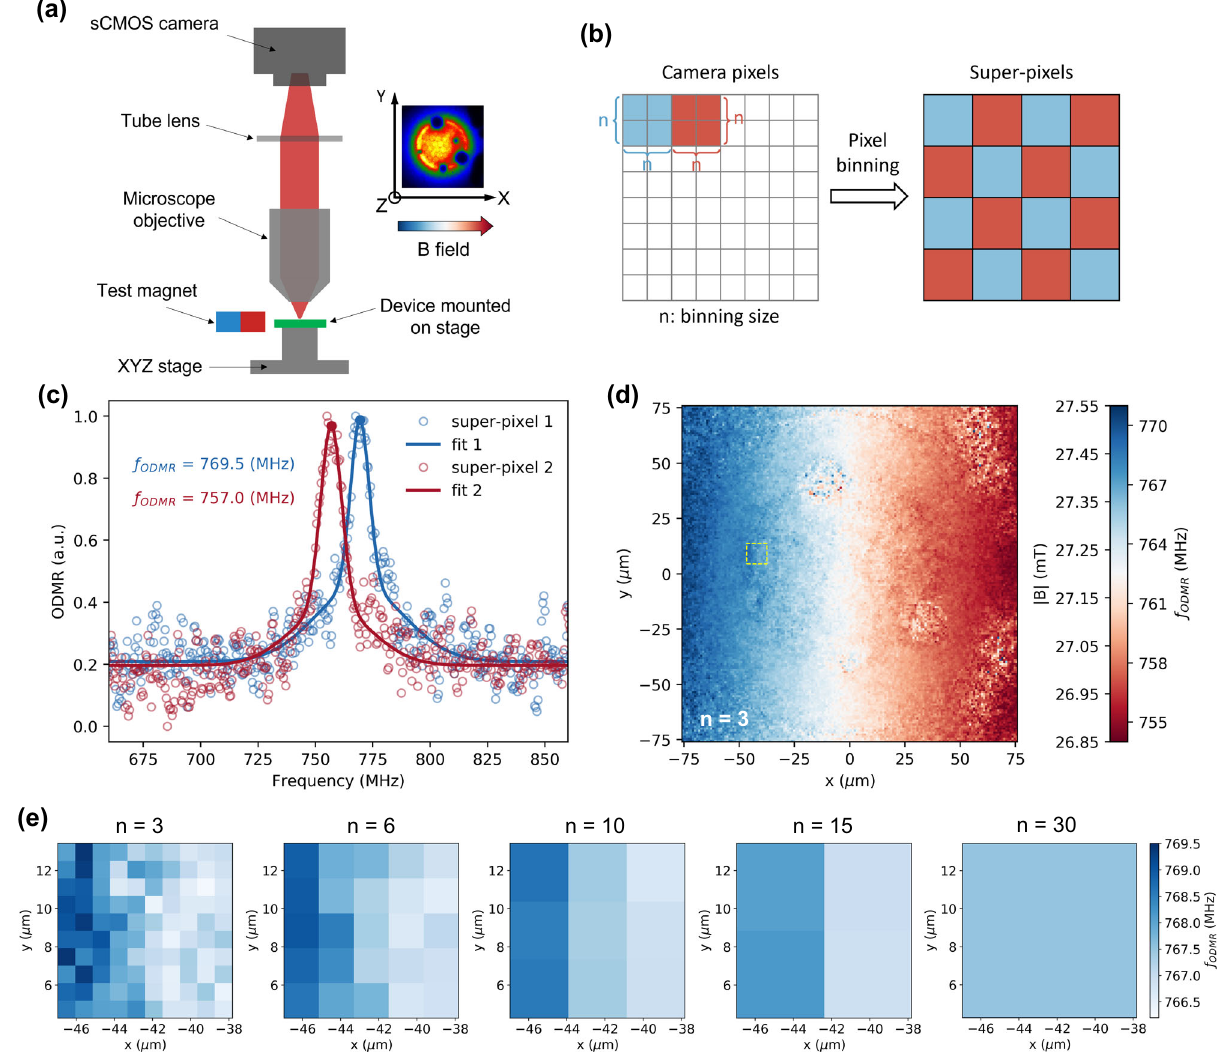
Fig. 3 | Spatiallyresolved ODMR-basedmagnetic fi eld mapping. a Sketch of the set-up for spatially resolved ODMR. The inset shows the image of EL intensity cap- turedbythesCMOScamera.TheB fi eldarrowrepresentsthemagnetic fi eldgradient across the OLED along x -direction in the horizontal x (cid:2) y plane. b Scheme of pixel binning where n × n adjacent camera pixels are merged into one combined pixel called “ super-pixel ” viapixelbinningprocess.Theopticalsignal(ELintensity)ofeach super-pixel is the average of the signals of all the n × n individual camera pixels. c Double Gaussian fi ts of ODMR spectrums of two super-pixels with binning size n =3. Super-pixel 1 and super-pixel 2 corresponds to the super-pixel at position of ( − 63.4 µ m,0.0 µ m)and(52.4 µ m,0.0 µ m)in d ,respectively.Thesolidcircledotslabel